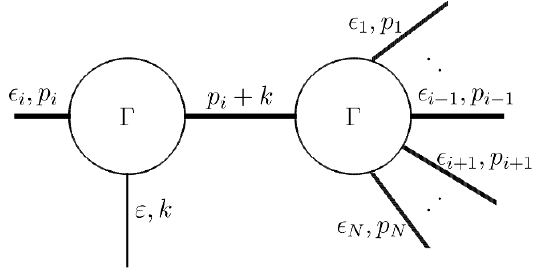
Figure 1 . The leading contribution.